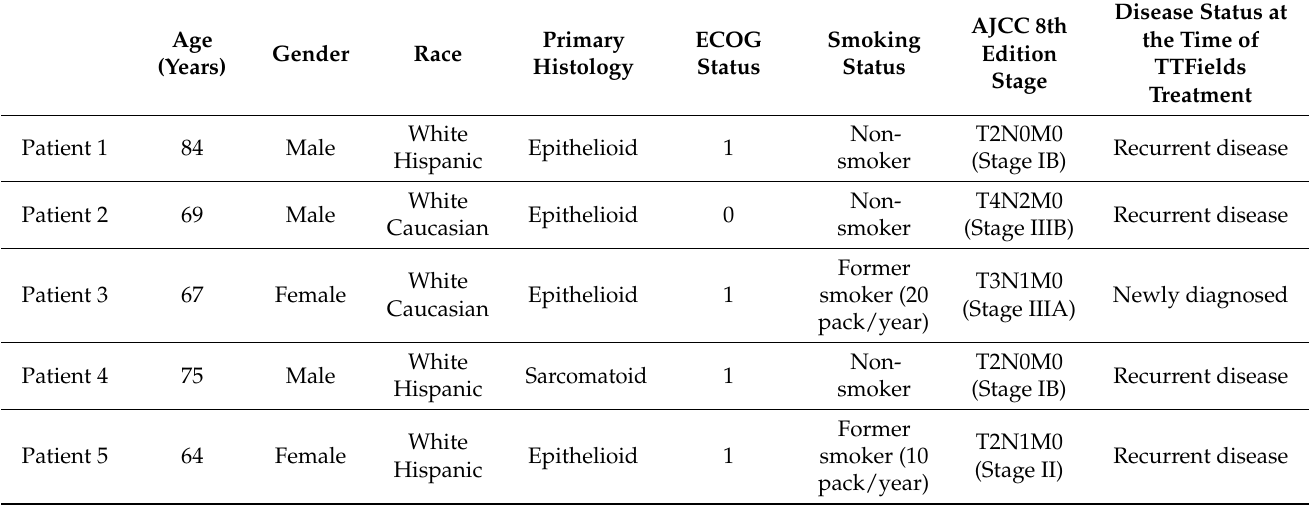
Table 1. Patient and disease